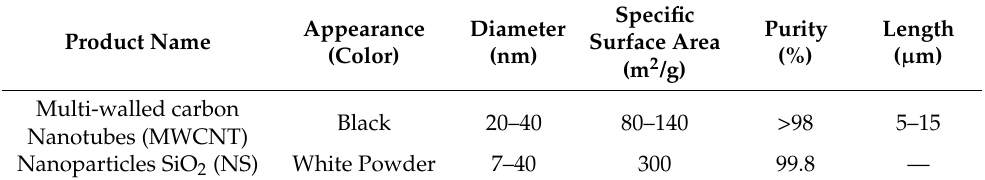
Table 2. Material properties of multi-walled carbon nanotubes (MWCNT) and nanoparticles SiO 2 (NS).